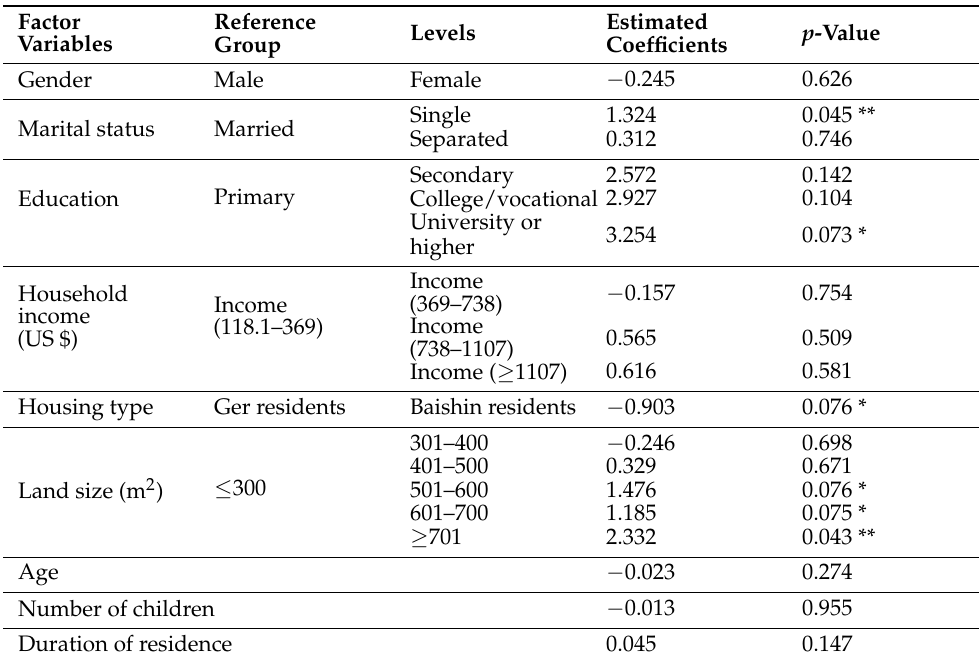
Table 3. Results of regression analysis regarding the ger respondents’ availability of sharing their land for park establishment (categorical and continuous